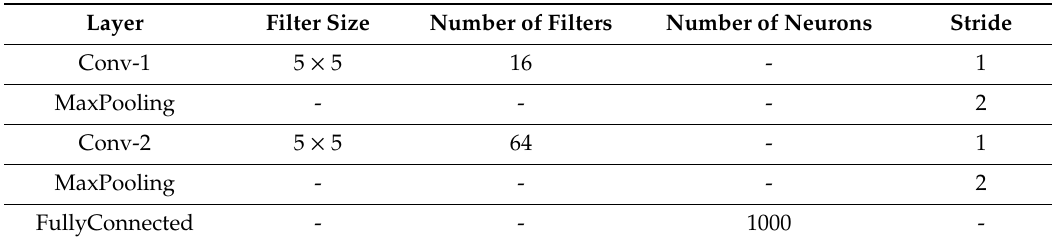
Table 2. Main Parameters of Convolutional Neural Network Model.